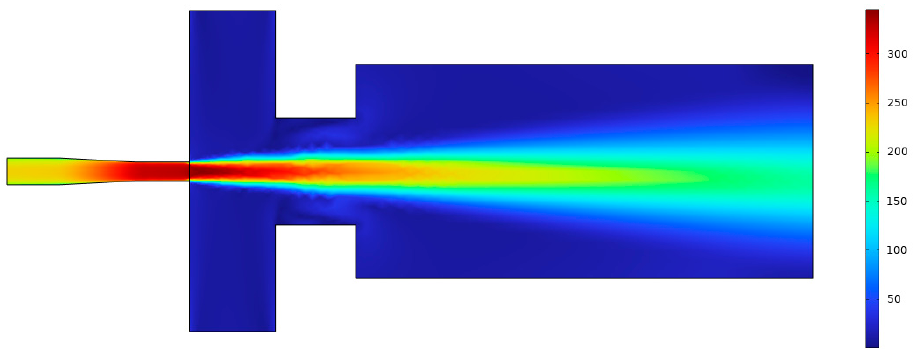
Figure 5. Flow-field analysis of hydraulic jet.